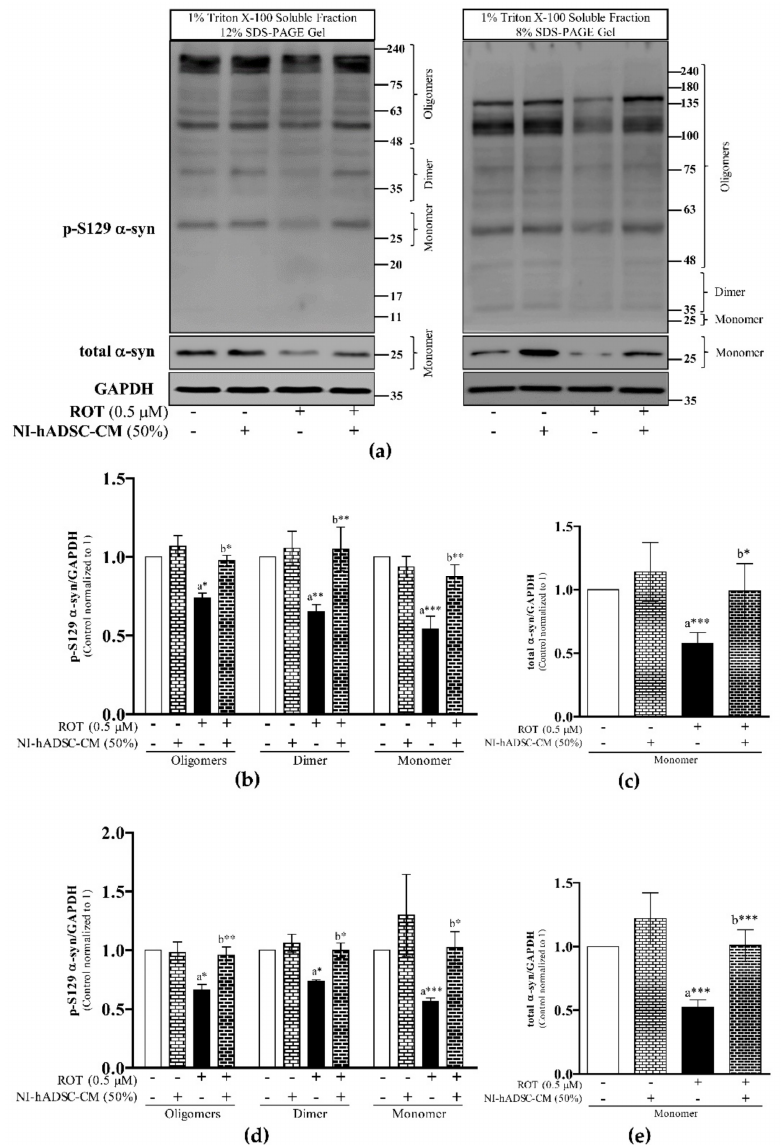
Figure 3. Effects of NI-hADSC-CM against ROT on p-S129 and total α -syn expressions in Triton X-100-soluble cell lysate fractions. SH-SY5Y cells were seeded at a density of 5 × 10 4 cells/mL in DMEM containing 1% FBS and used for the experiments after overnight incubation. Cells incubated in the absence or presence of ROT (0.5 µ M) for 48 h were treated with NI-hADSC-CM (50%) during the last 24 h. Cell lysates were prepared as 1% Triton X-100 soluble and insoluble (2 × SDS-soluble) fractions. The expression levels of p-S129- and total α -syn were analyzed from 1% Triton X-100 soluble fractions by Western blotting using 12 and 8% SDS-PAGE gels ( a ). Images are representative of three independent experiments. The bar graphs represent fold changes in p-S129 α -syn/GAPDH ( b , d ) and total α -syn/GAPDH ( c , e ) in 12% ( b , c ) or 8% ( d , e ) SDS-PAGE. Data are presented as the mean ± SEM of three independent experiments. Statistical analysis was performed using one-way analysis of variance (ANOVA) followed by Tukey’s post hoc test. Statistical significance: a—compared with control; b—compared with ROT; * p < 0.01, ** p < 0.05, and *** p <